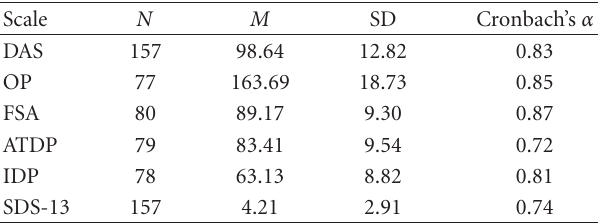
Table 2: Descriptive statistics and reliability for the DAS, OP, FSA, ATDP, IDP, and SDS-13.